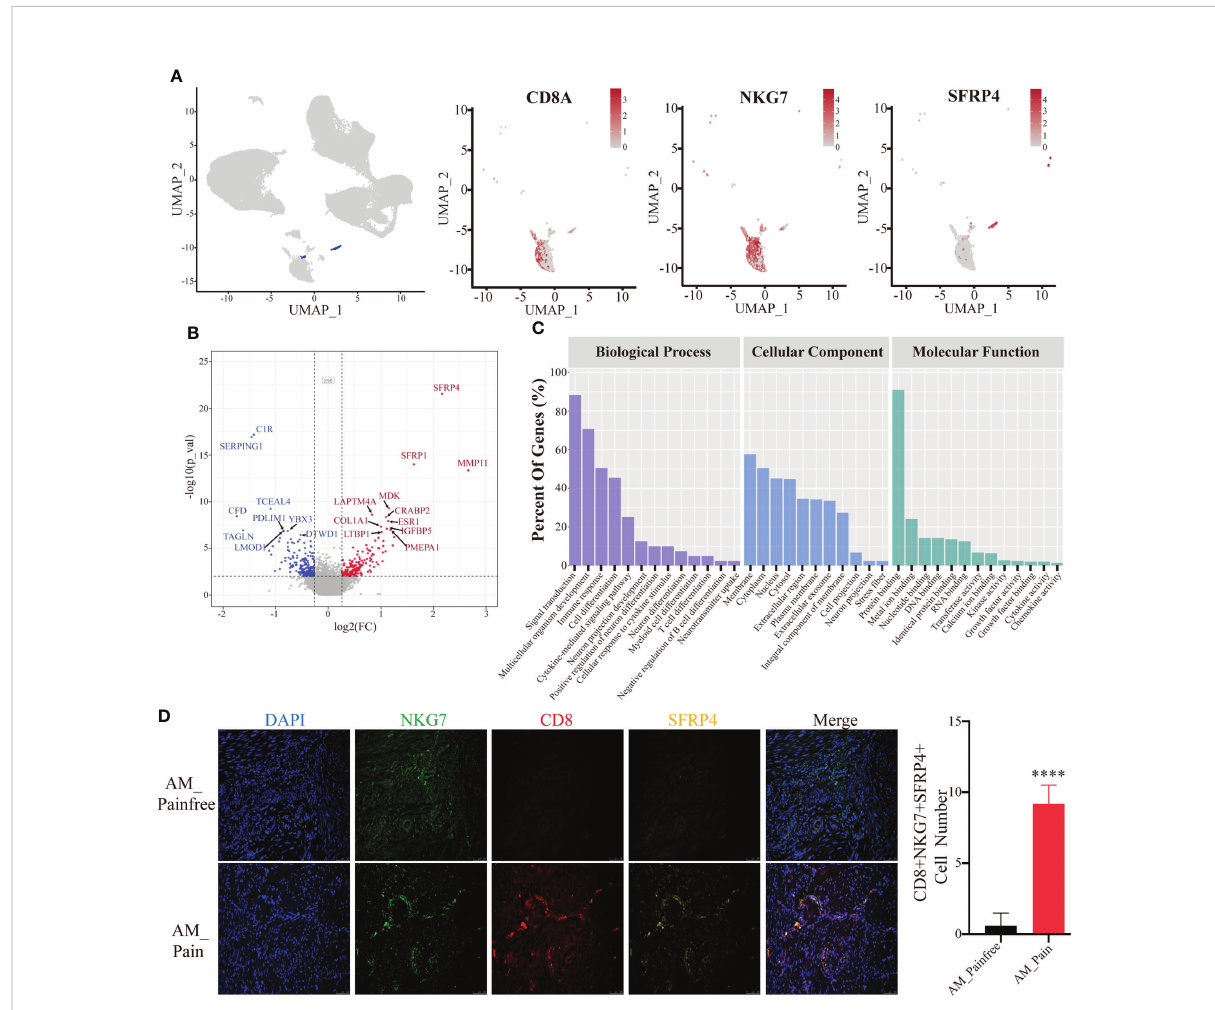
FIGURE 2 SFRP4 + NKT cells are speci fi cally present in the AM_Pain group. (A) CD8, NKG7, and SFRP4 de fi ne the cluster 24 cell population. (B) Comparison of differential genes in cluster 24 cell groups (AM_Painfree group vs . AM_Pain group). (C) GO analysis of cluster 24 cell populations. (D) SFRP4-speci fi c expression in NKT cells in the AM_Pain